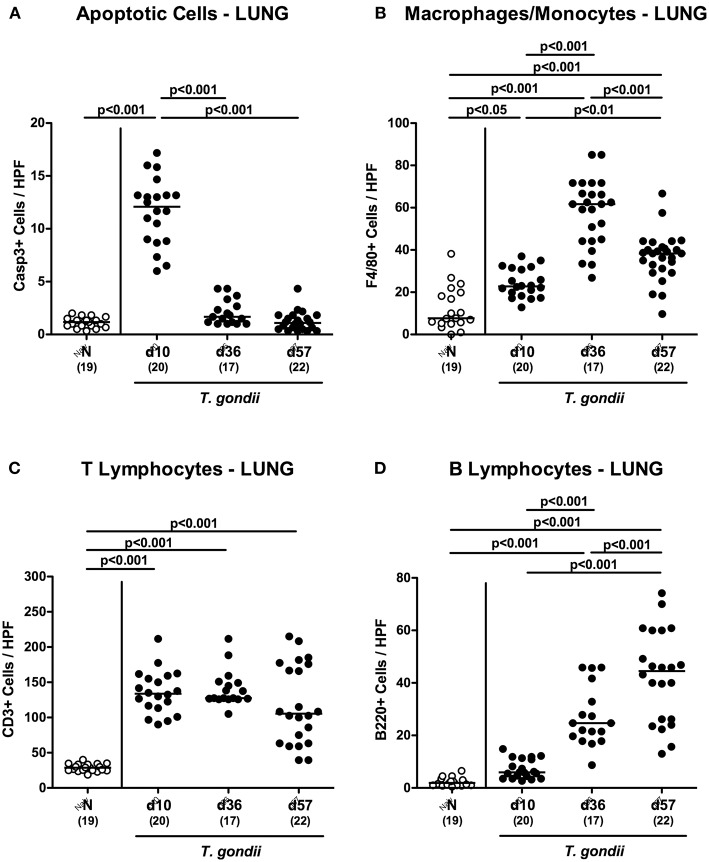
Microscopic inflammatory sequelae in the lungs over time following peroral low-dose T. gondii infection. Mice were perorally infected with one cyst of T. gondii on day 0 and surveyed at days (d) 10, 36, and 57 post-infection (p.i.; closed circles). Naive (N) mice served as uninfected controls (open circles). Out of six representative high power fields (HPF, 400x magnification) per animal the average numbers of (A) apoptotic (casapse3+, Casp3+) cells, of (B) macrophages and monocytes (F4/80+), of (C) T lymphocytes (CD3+) and (D) B lymphocytes were assessed in immunohistochemically stained pulmonary paraffin sections. Medians (black bars), levels of significance (p-values) as determined by one-way ANOVA test followed by Tukey post-correction for multiple comparisons and numbers of analyzed mice (in parentheses) are indicated. Data were pooled from four independent experiments.